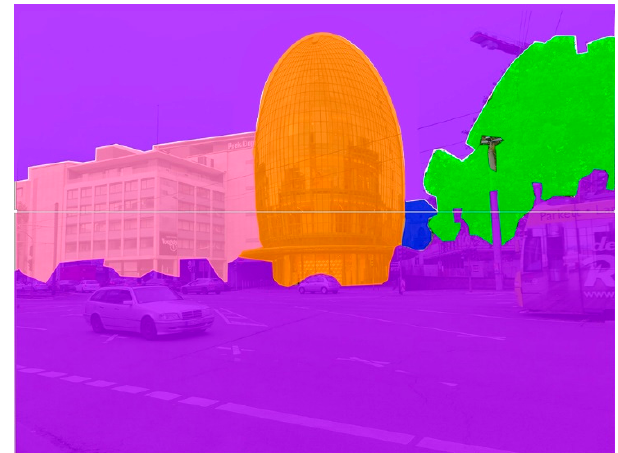
Figure 6. Areas of interest and the unclassified area outlined for image 2, legend: area 2AOI1—orange, area 2AOI2—blue, area 2AOI3—pink, area 2AOI4—green, area Not on